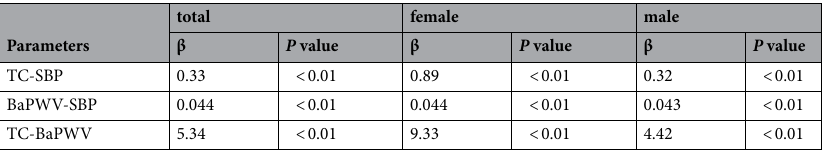
Table 2. Associations among TC, BaPWV, and SBP. Adjust age, gender (in total), waist circumference, fasting blood glucose, physical exercise, smoking, alcohol consumption, heart rate, antihypertension, glucose-lowering